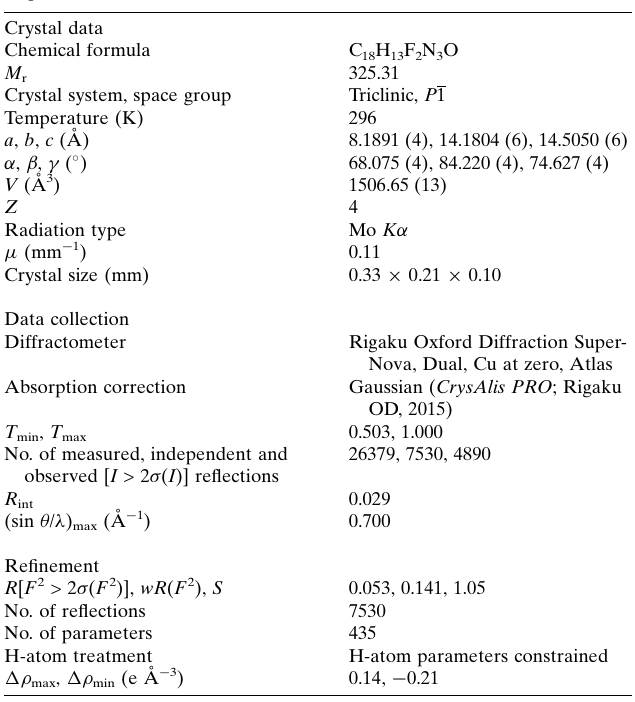
Table 2 Experimental details.